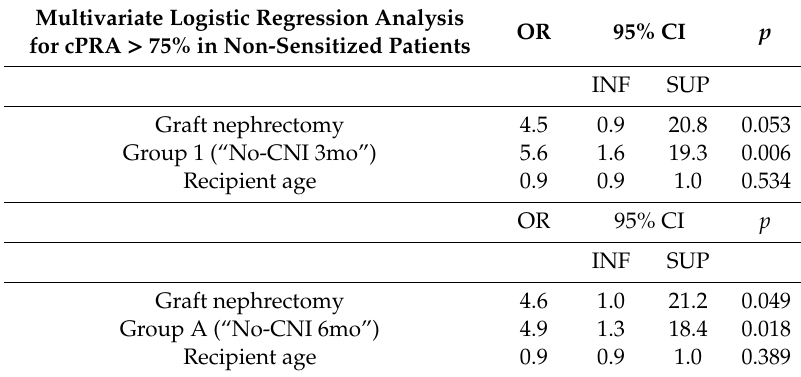
Table 4. Results of the multivariate logistic regression analysis for cPRA > 75% in previously non-sensitized patients. The bold: p values less than 0.05 defined statistical